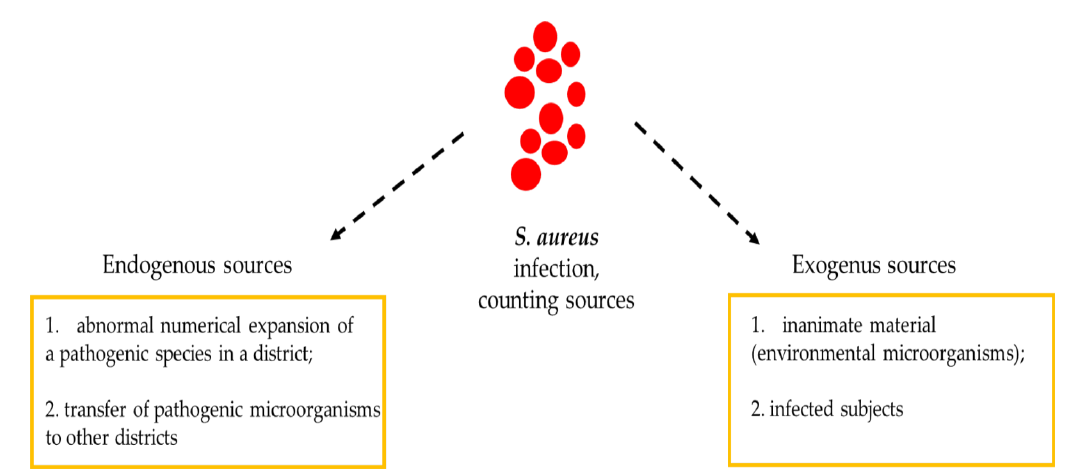
Figure 2. Sources of contagion for Staphylococcus aureus infections.